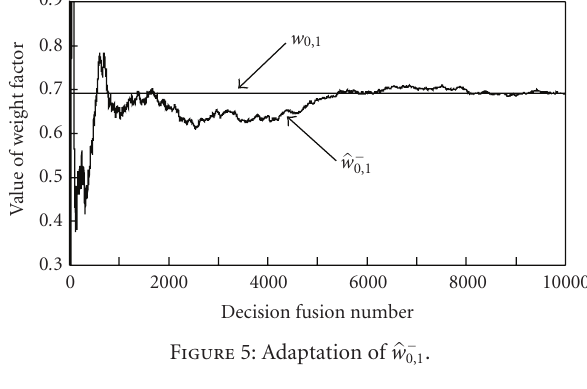
Figure 5: Adaptation of (cid:18) w − 0,1 .